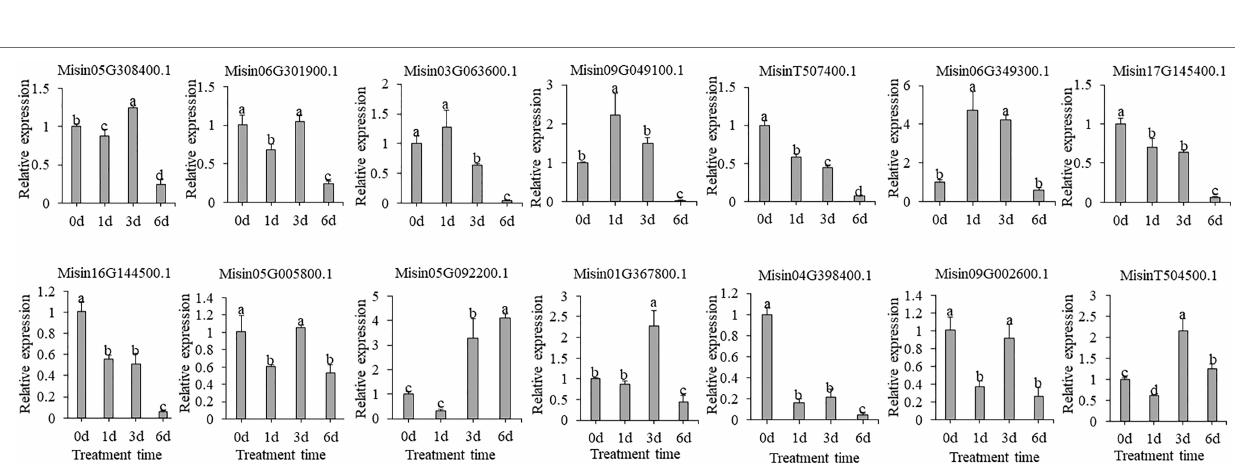
FIGURE 6 | Expression profiles of 14 selected M. sinensis NAC genes in response to salinity treatment. Data were normalized to reference gene Unigene33024, and vertical bars indicate SD. No common letter above bar indicates a significant difference by least significant difference (LSD; p < 0.05).